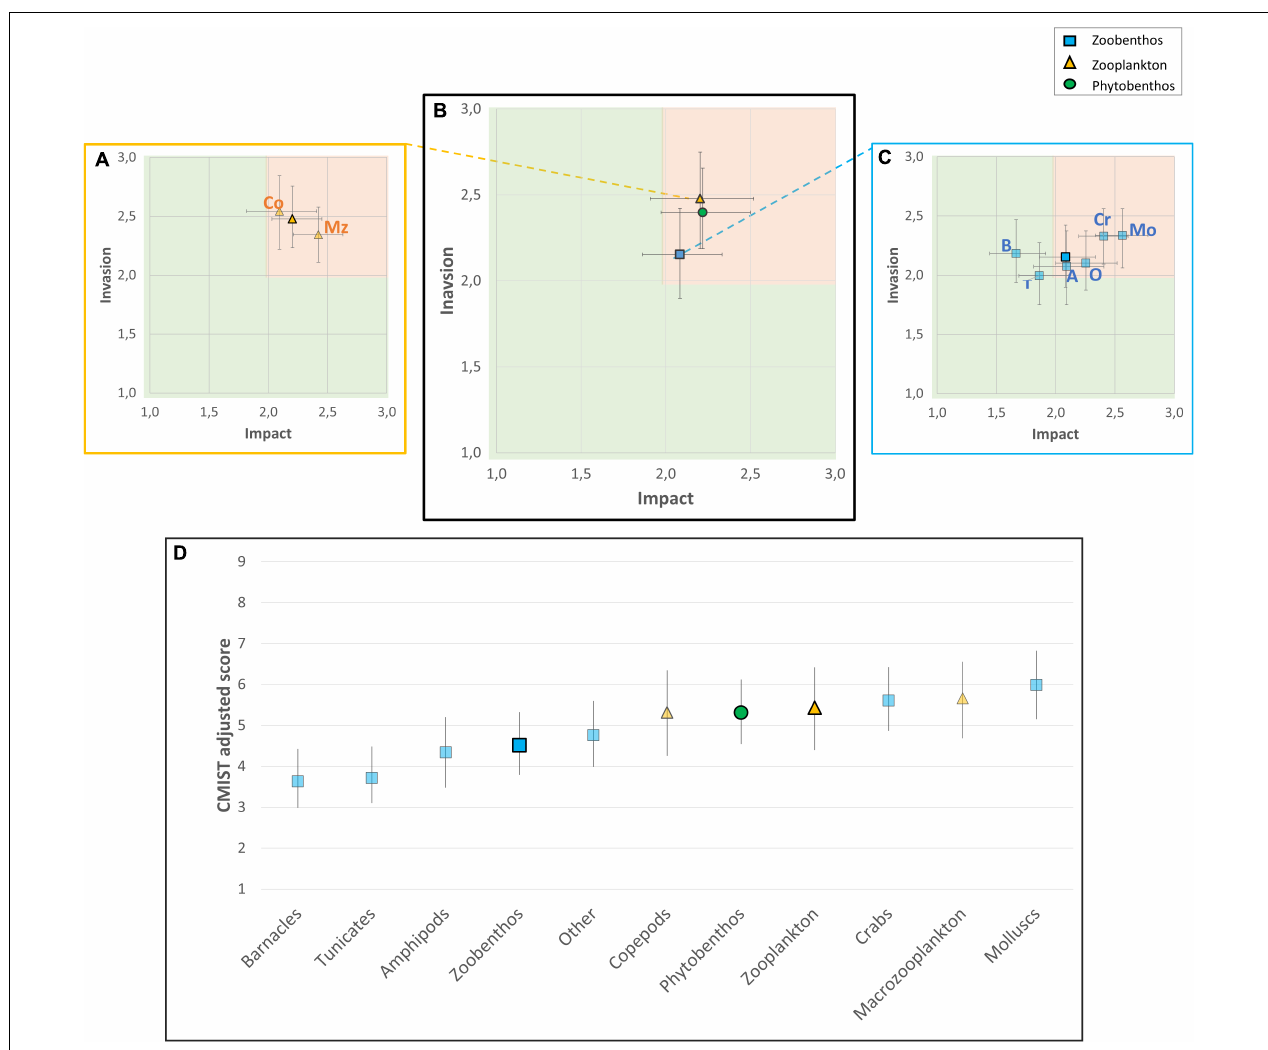
FIGURE 4 | Heat matrices depicting adjusted average values of likelihood and impact of invasion scores by ecological groups (A) and taxonomic groups in the Hudson Bay Complex (B,C) , and ranked average CMIST risk scores for ecological and taxonomic groups (D) . Error bars represent the mean of upper and lower 95% confidence limits of each category/group. Symbols of ecological categories are in bold while taxonomic groups therein are in lighter colors (Co: copepods; Mz: macrozooplankton; B: barnacles; T: tunicates; A: amphipods; O: other zoobenthos; Cr: crabs; Mo: mollusks).